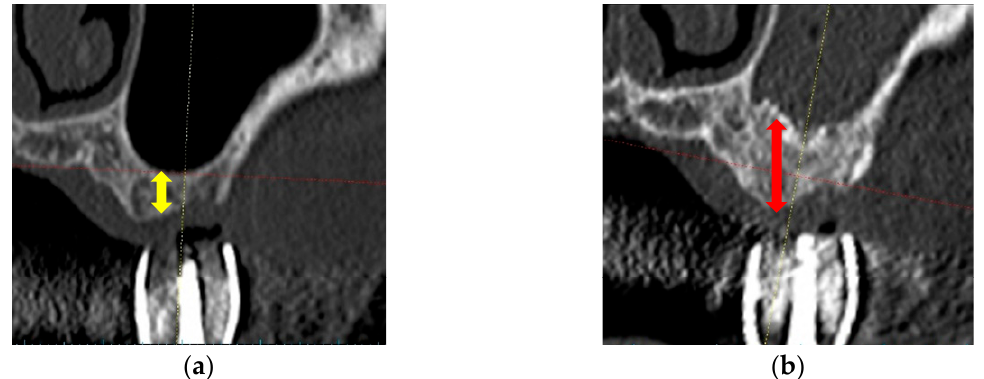
Figure 3. CT images of pre-SFE and pre-implantation. ( a ) Pre-SFE (frontal view), the yellow allow